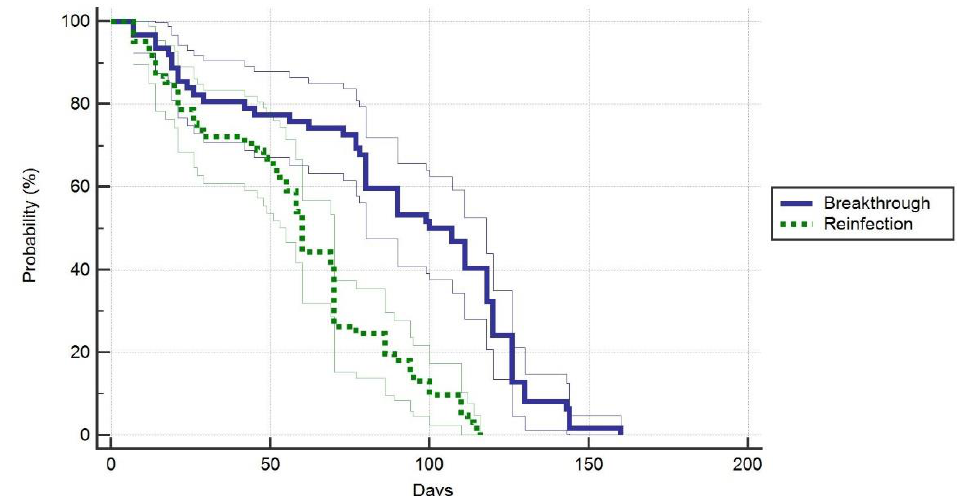
Figure 1. Probability of duration until breakthrough after second vaccine dose or reinfection in unvaccinated patients.